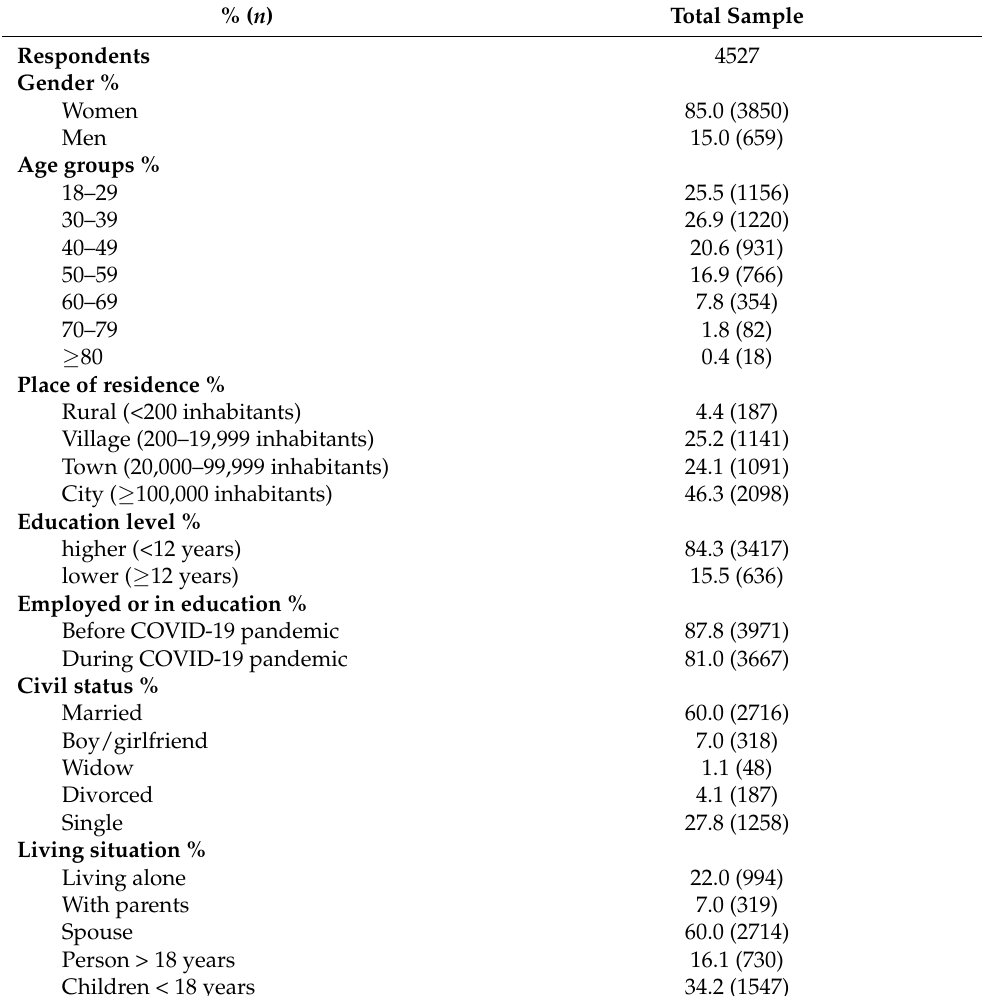
Table 2. Sociodemographic